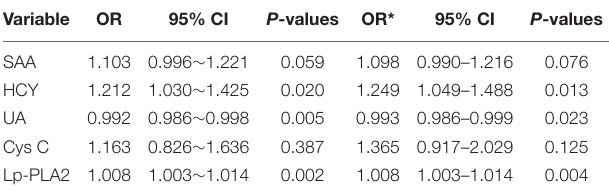
TABLE 6 | Logistic regression analysis of the risk factors of PD.